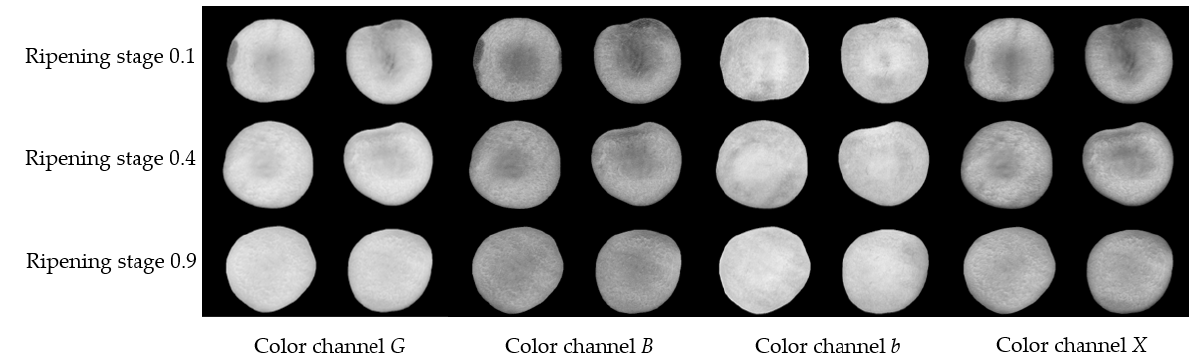
Figure 4. The slice images of ‘Redhaven’ peaches in different color channels.